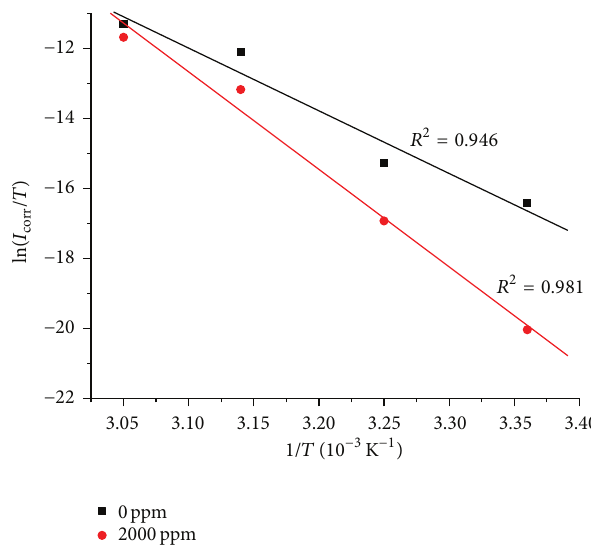
Figure 5: Arrhenius plot for ln (𝐼 corr /𝑇) versus 1/𝑇 in 0.5 MH 2 SO 4 without and with inhibitor